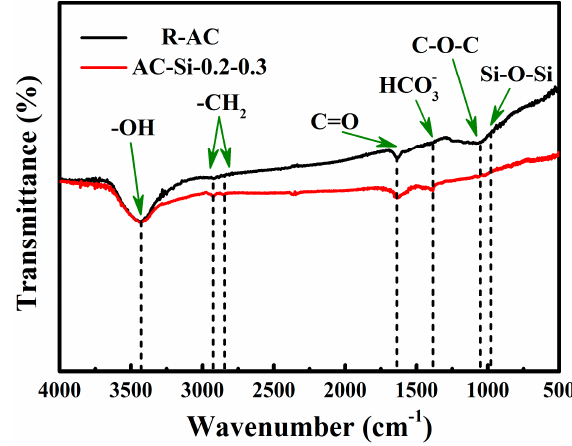
Figure 8. The Infrared Spectroscopy of AC-Si-0.2-0.3 and R-AC.